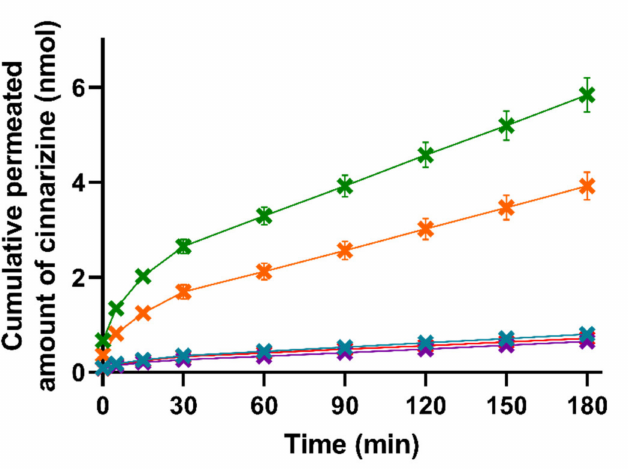
Figure 4. Mean cumulative permeated amount of cinnarizine as a function of time when studying the five formulations SNEDDS 80% (green), superSNEDDS suspension (blue), superSNEDDS solution (purple), the Chasing principle (orange), and aqueous suspension (red) in the lipolysis-permeation method. The data are presented as the mean ± SEM ( n =